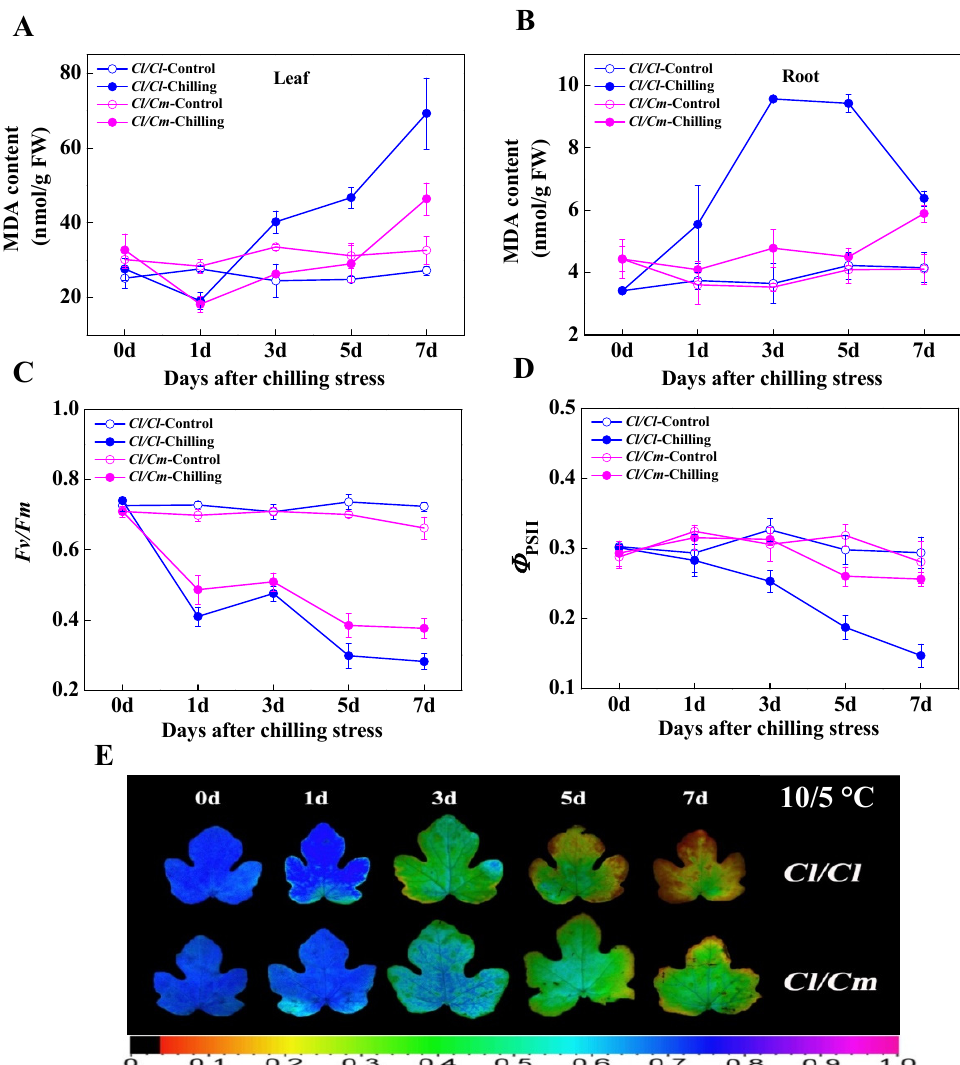
Figure 1. Pumpkin rootstock-induced chilling tolerance in grafted watermelon plants. ( A ) Changes in malondialdehyde (MDA) content in the leaves under chilling stress. ( B ) Changes in MDA content in the roots under chilling stress. ( C ) Average values of the maximum quantum yield of PSII ( F v/ F m). ( D ) Average values of the effective quantum yield of PSII ( Φ PSII ). ( E ) Images of F v/ F m under chilling stress. Leaf or root samples were collected at indicated times under control (28/18 °C) and chilling (10/5 °C) conditions. Cl / Cl , self-grafted watermelon plants; Cl/Cm , pumpkin rootstock-grafted watermelon plants. The data are the means of four replicates with SEs. The color gradient of the images in F v/ F m provided at the bottom of Figure 1E ranged from 0 (black) to 1.0 (purple).